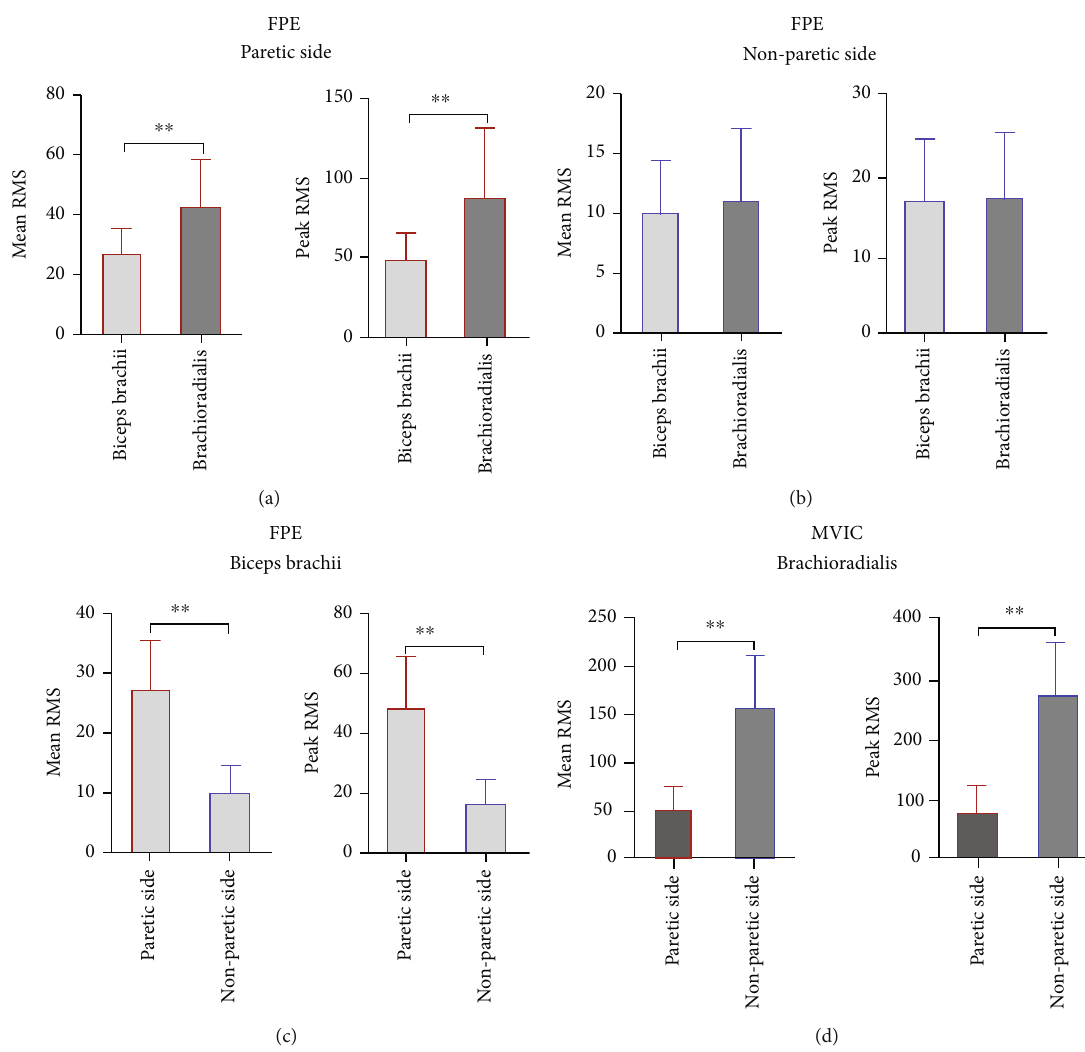
Figure 4: sEMG signals of the elbow fl exor muscles (the biceps brachii and brachioradialis) during FPE. (a) Mean RMS values of the biceps brachii and brachioradialis during FPE on the paretic side. (b) Peak RMS values of the biceps brachii and brachioradialis during FPE on the nonparetic side. (c) Mean RMS values of the biceps brachii during FPE on the paretic and nonparetic sides. (d) Mean RMS values of the biceps brachii during FPEon the paretic and nonparetic sides. sEMG: surface electromyography; FPE: fast passive extension; RMS: root mean square; ∗ p < 0 : 05 ; ∗∗ p < 0 : 005